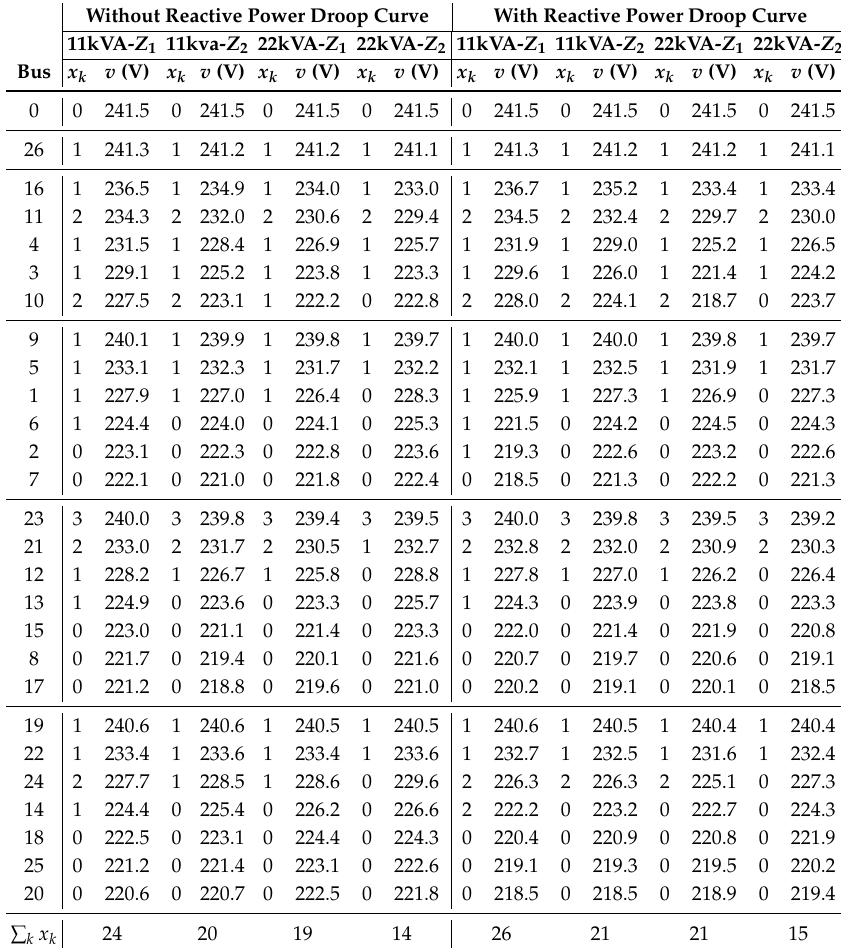
Table 5. Case study: Selection of charging points and voltage